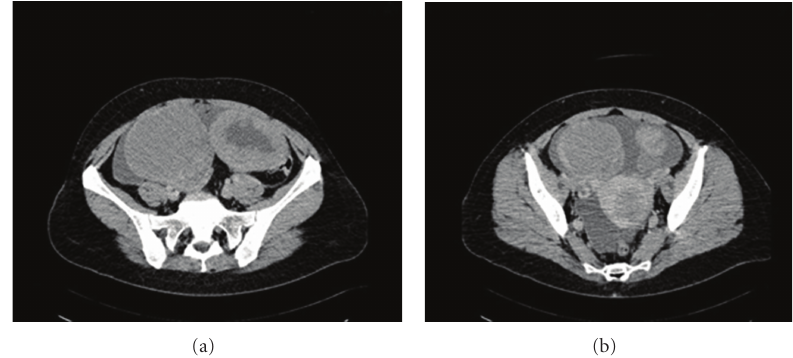
Figure 2: Computed tomography (CT) showed (a) a partially necrotic solid mass measuring 9.5 cm in diameter in the left side of the pelvis and a cystic tumor in right side measuring 10.5 cm. (b) The uterus presented an heterogeneous myometrial structure with a nodular lesion 4cm long.